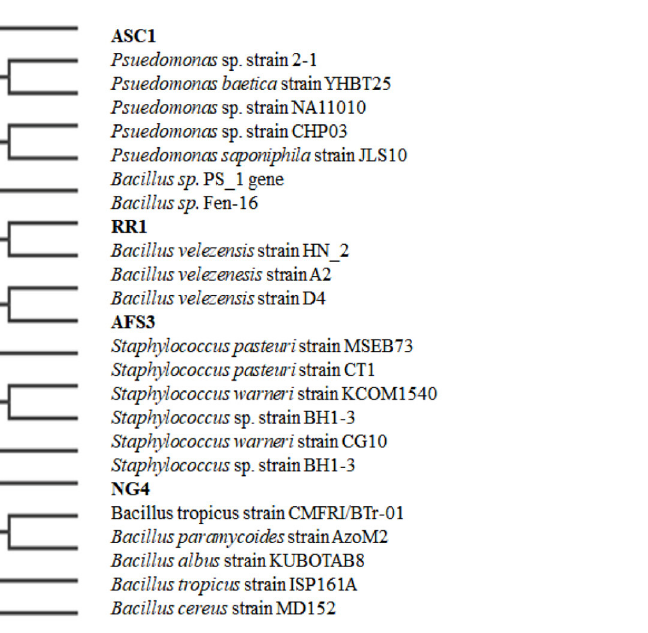
trait as this plant hormone help in plant growth, root development, tissue formation, cell elongation, etc. (Tsavkelova et al., 2007). In